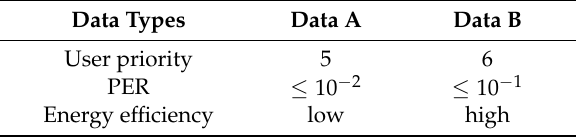
Table 1. QoS requirements of different data types.